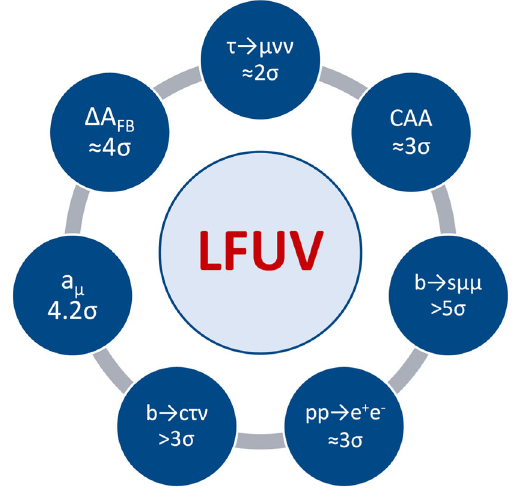
Fig. 1 Summary of the experimental hints for LFUV beyond the